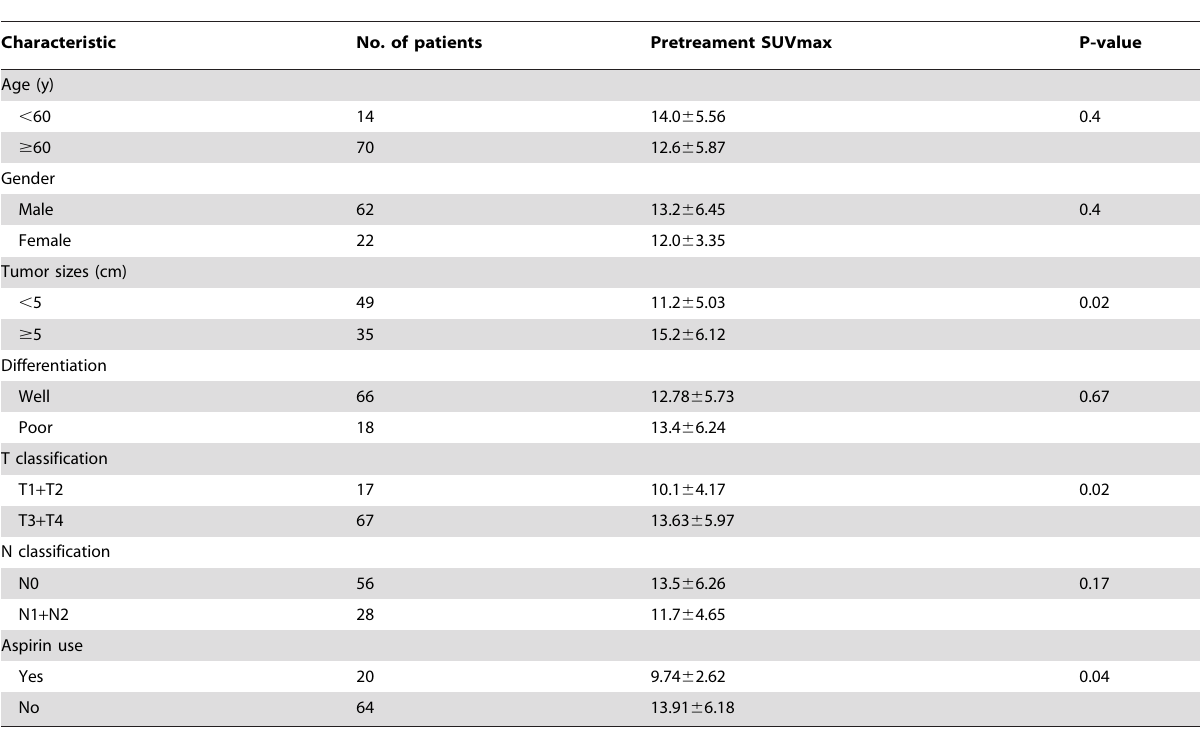
Table 2. Clinicopathological implication of Pretreament SUVmax combination